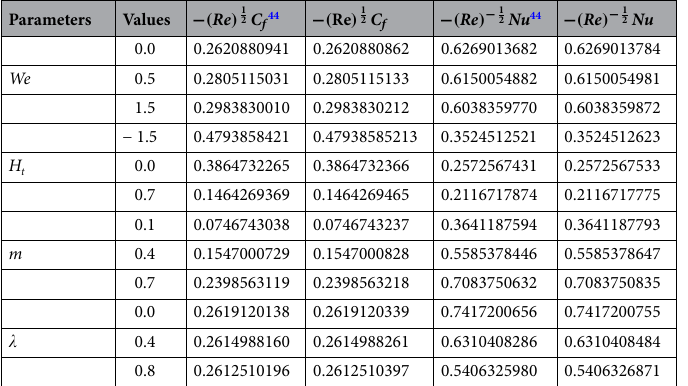
( Re ) 1 2 C f and Nusselt number −